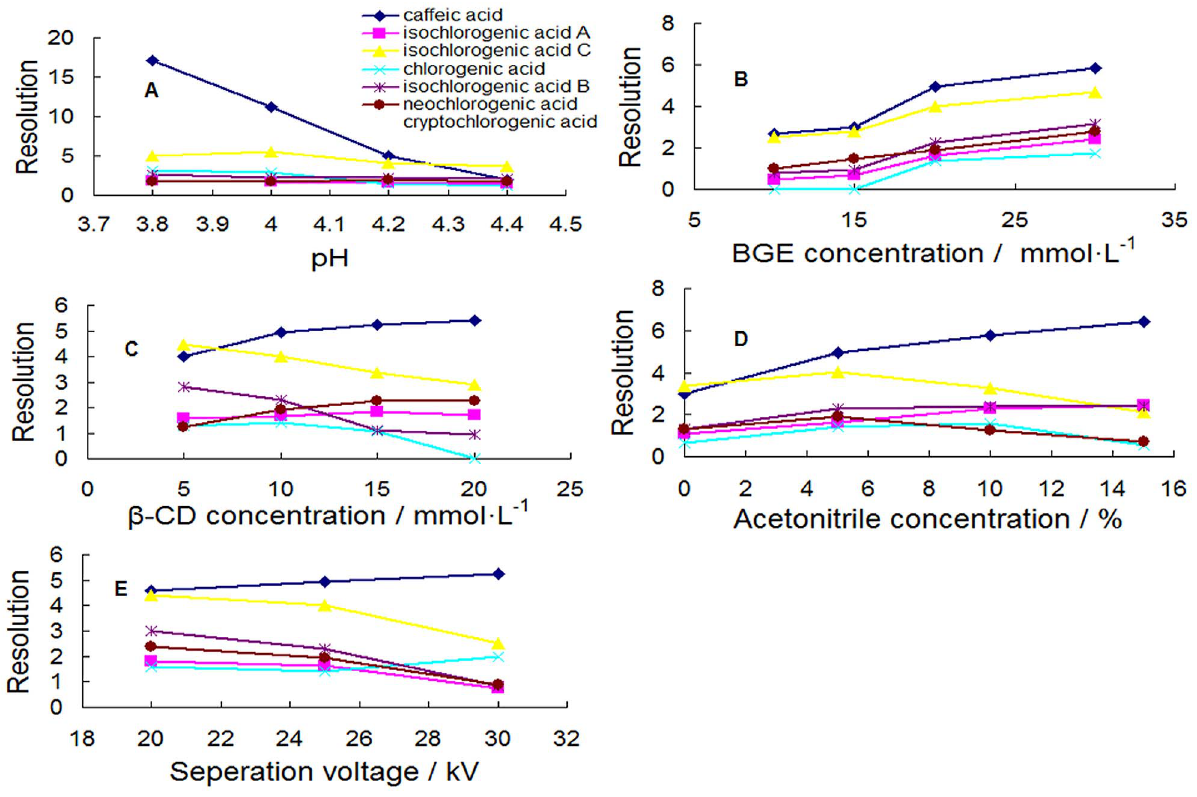
Figure 3. Effects of parameters on the resolution of seven peaks (n=3). (A) pH of the phosphate buffer, (B) BGE concentration, (C) b -CD concentration, (D) acetonitrile concentration, (E) separation voltage.